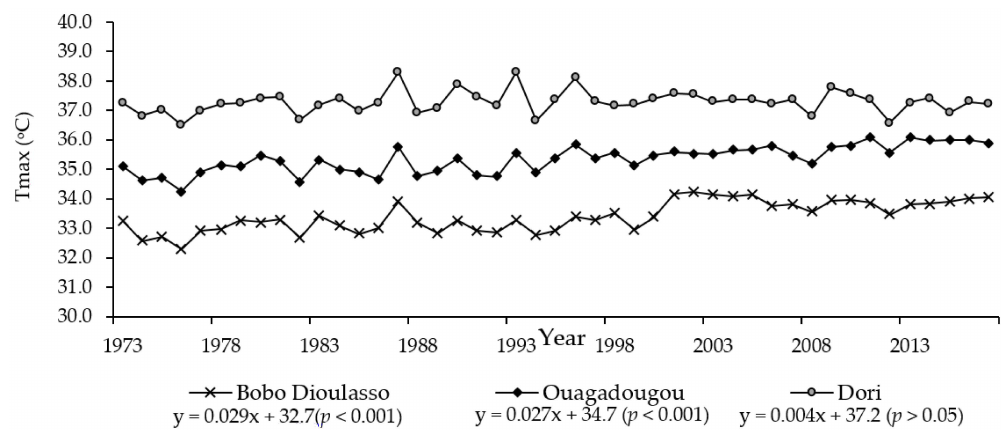
Figure 2. Mean annual maximum temperature (Tmax), lineal regression, and statistical significance along the different agroclimatic zones (Soudanian, Soudano-Sahelian, and Sahelian) for the period 1973–2017.